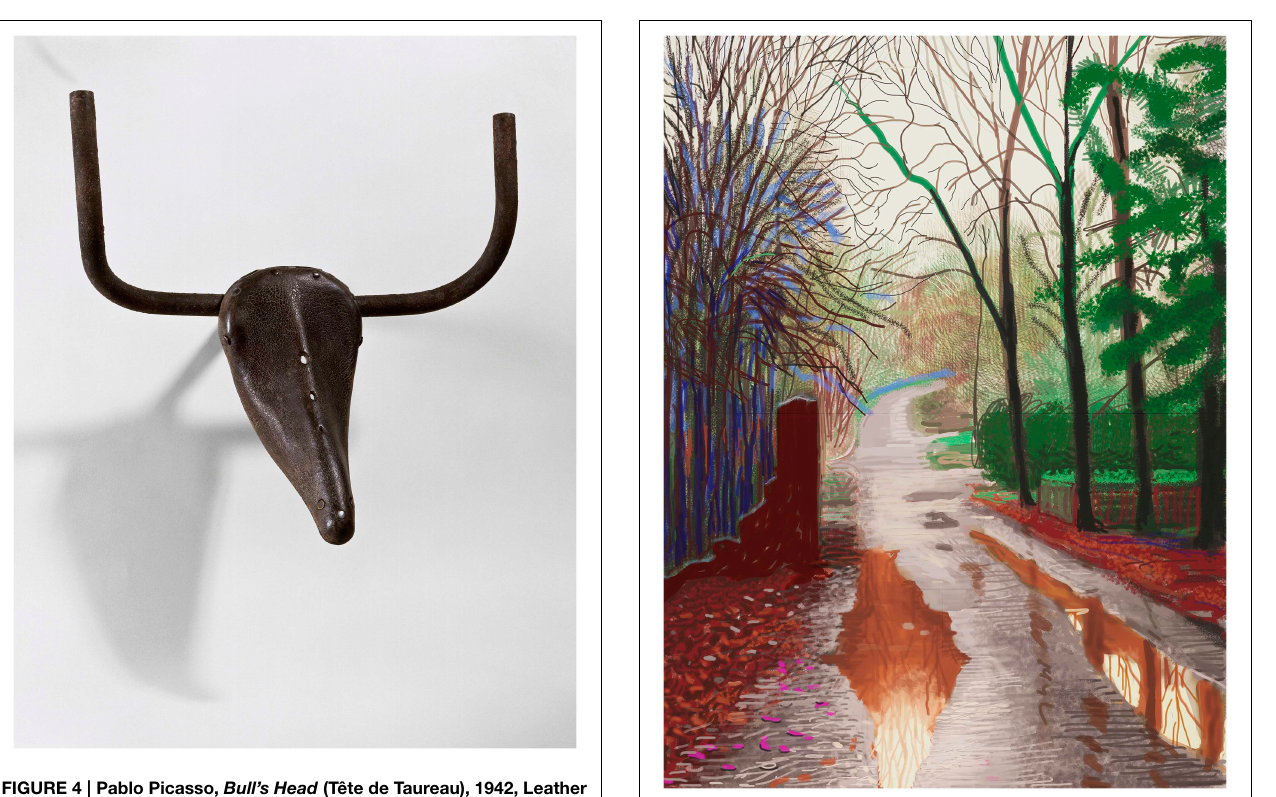
FIGURE 5 | David Hockney, The Arrival of Spring in Woldgate, East Yorkshire in 2011 (twenty eleven)–29 December, No. 2 , iPad drawing printed on four sheets of paper (46 1/ 2 × 35 ′′ each), mounted on four sheets of Dibond, Edition of 10, 93 × 70 ′′ overall. © David Hockney. Photo Credit: Richard